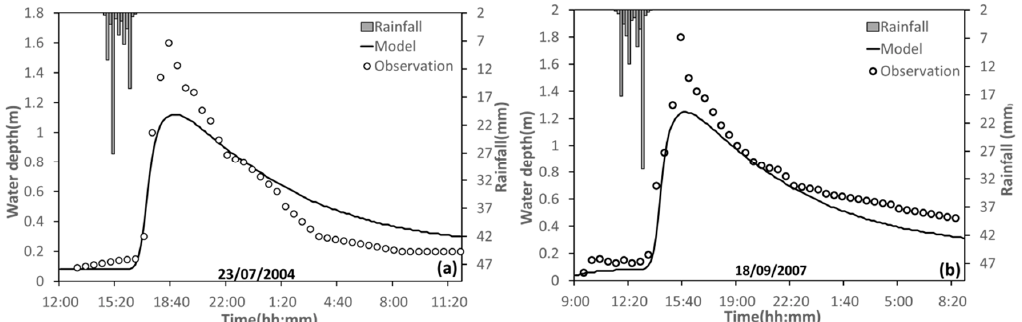
Figure 2. Simulated and observed water depths in calibration ( a ) and validation ( b ).